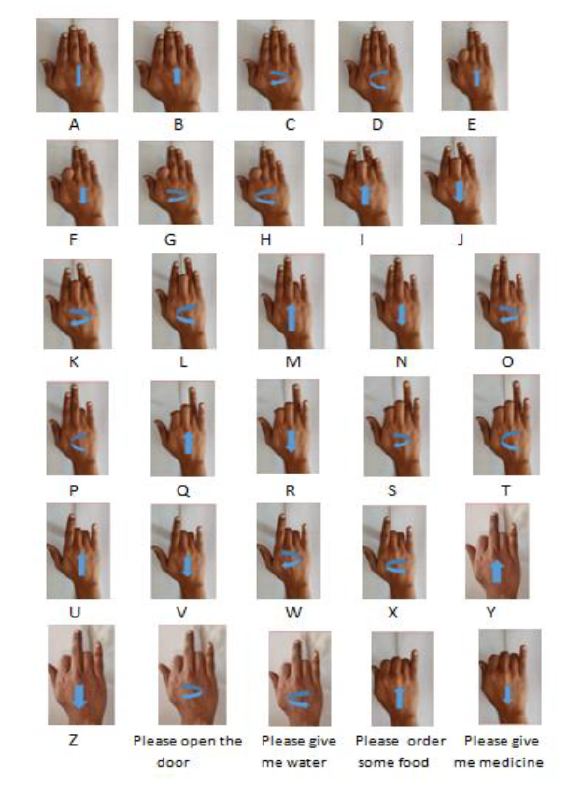
Figure 7: Hand Gestures